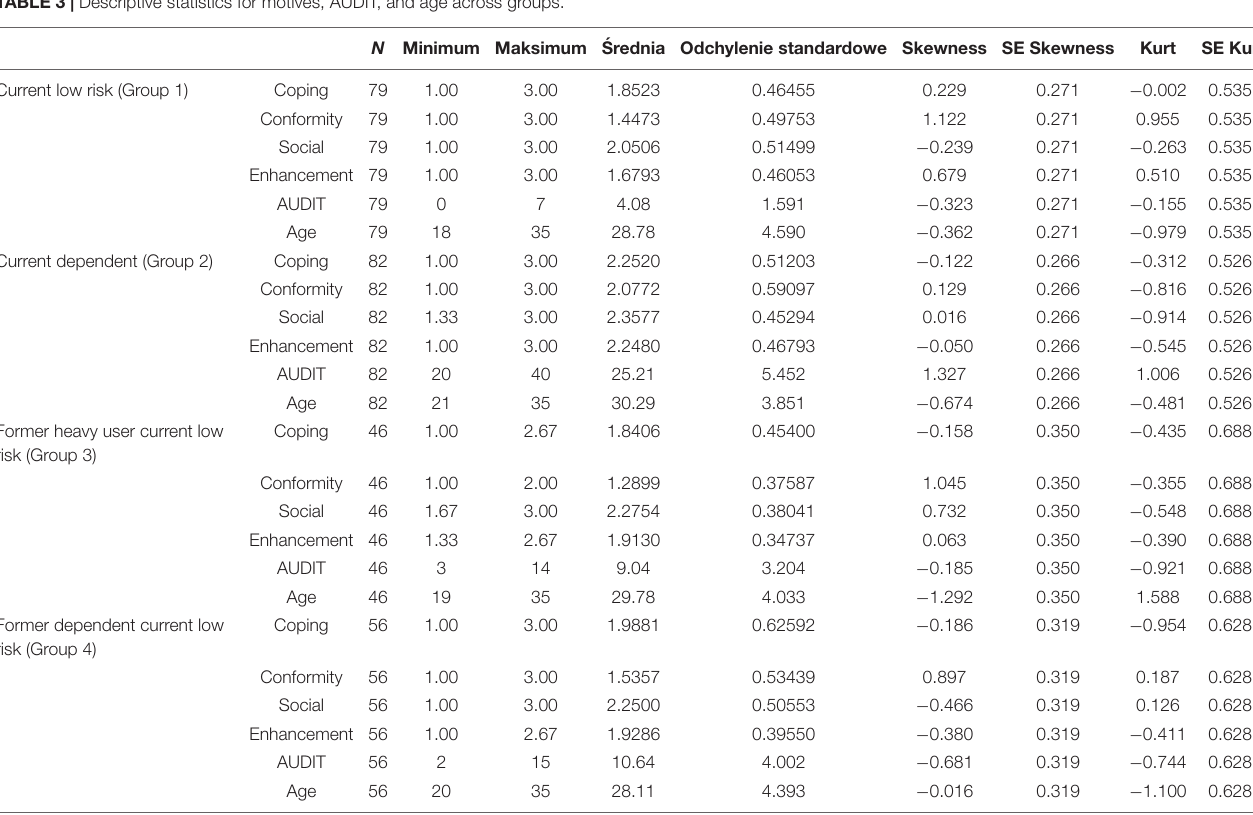
TABLE 3 | Descriptive statistics for motives, AUDIT, and age across